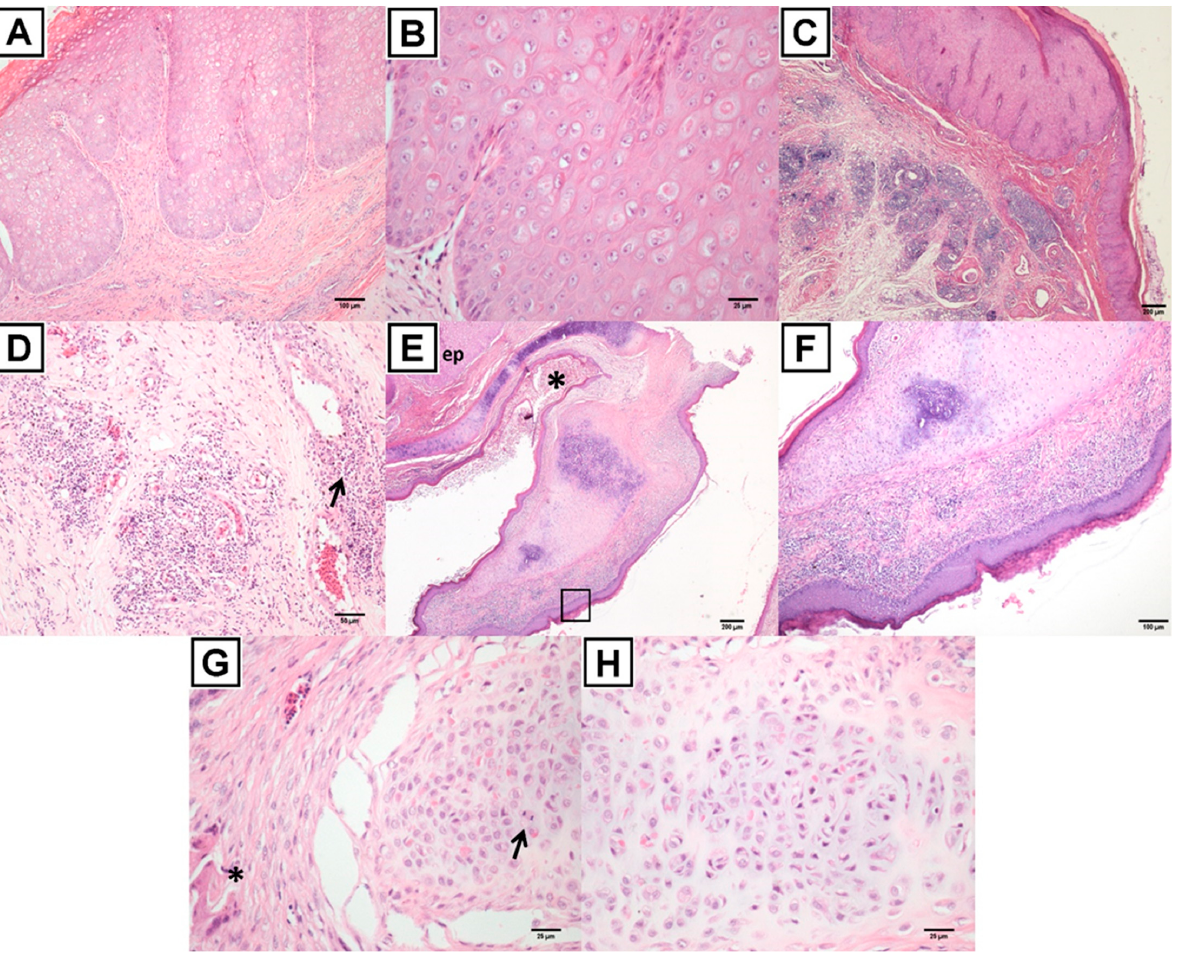
Figure 6. Photomicroscopy of the upper corneous beak and rostral nasal chamber. ( A ) Cornealized keratinized epithelium of the upper beak showing classic poxviral lesion, with irregular hyperplasia, ballooning, and intracytoplasmic inclusion corpuscle. ( B ) Zoomed-in hyperplastic epithelium with ballooned keratinocytes and intracytoplasmic inclusion corpuscle. ( C ) Transition region between epithelial proliferation with ballooning keratinocytes and intracytoplasmic inclusion corpuscle. Moderate perivascular inflammatory infiltrate in the lamina propria and nerve periphysis. ( D ) Zoomed-in C showing perivascular inflammatory infiltrate of lymphocytes, plasmocytes, and histiocytes. H&E staining. ( E ) Rostral nasal chamber shows hyperplasia of keratinocytes in the epithelium (ep) with Bollinger corpuscles. Lumen of the rostral nasal chamber with cell debris and erythrocytes (*). ( F ) Zoomed-in nasal septum with moderate inflammatory infiltrate in the lamina propria with exocytosis of heterophiles. Lymphoplasmacytic rhinitis. Notice an irregular cartilage. ( G ) Ventral region of the rostral nasal chamber and roof of the oral cavity where there are foci of infiltration of multinucleated giant cells (*) and choana cartilage with chondrocytes in mitosis (arrow), showing intracytoplasmic eosinophilic inclusion bodies (Bollinger corpuscles). ( H ) Nasal cartilage showing irregular chondrocytes and intracytoplasmic eosinophilic inclusion corpuscles (Bollinger corpuscles). H&E staining.